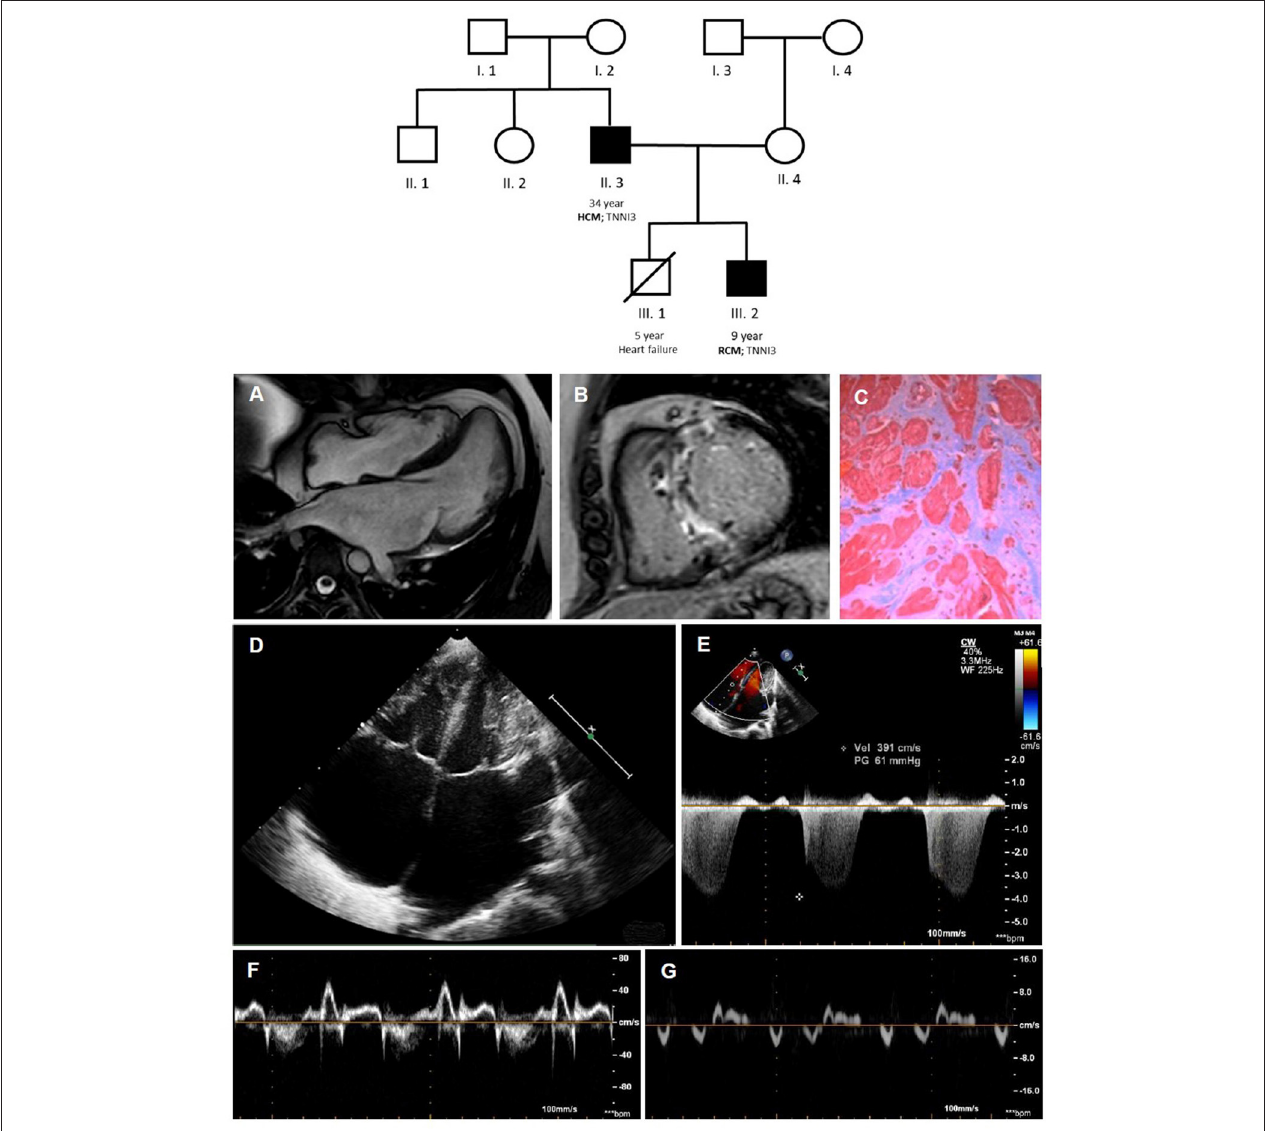
FIGURE 2 | Coexistence of HCM [father; II.3; (A–C) ] and RCM [son; III.2; (D–G) ] within the same family, due to a pathogenetic troponin I mutation. In the family tree, black filled symbols stand for affected carriers. Cardiac magnetic resonance shows mild septum hypertrophy with mild left atrial enlargement (A) and septal late gadolinium enhancement (B) and replacement fibrosis at optical microscopy (C) . The echocardiogram (D–G) shows a pediatric RCM with severe biatrial enlargement and small left ventricular volume (D) with signs of increased filling pressures at Doppler and TDI evaluation. HCM, hypertrophic cardiomyopathy; RCM, restrictive